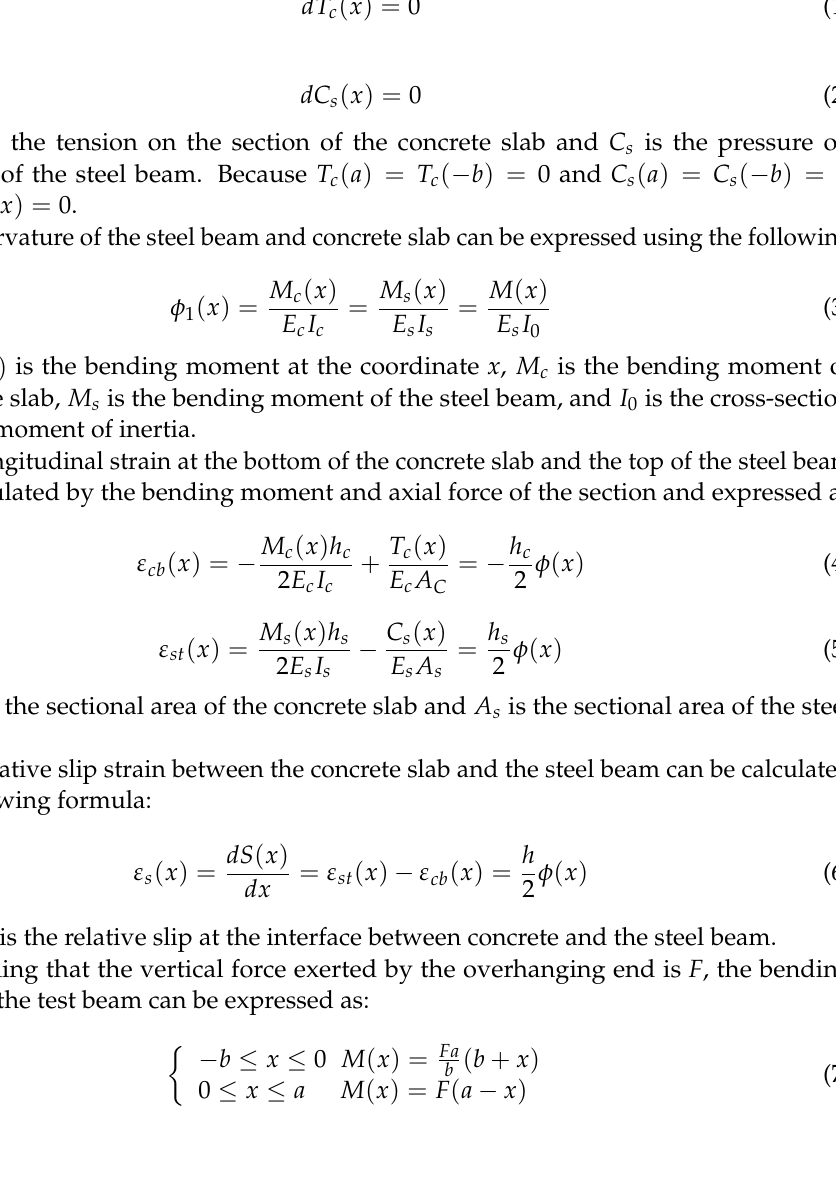
Figure 9. Internal force distribution in a microsegment of the beam.